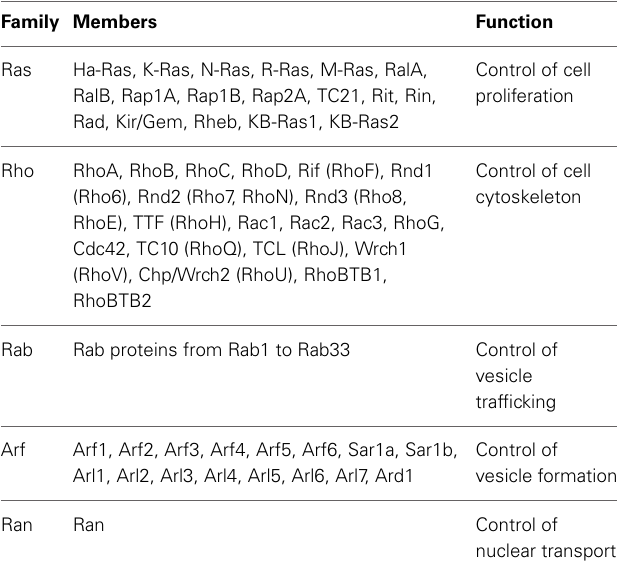
Table 1 | Members of the Ras superfamily and their major